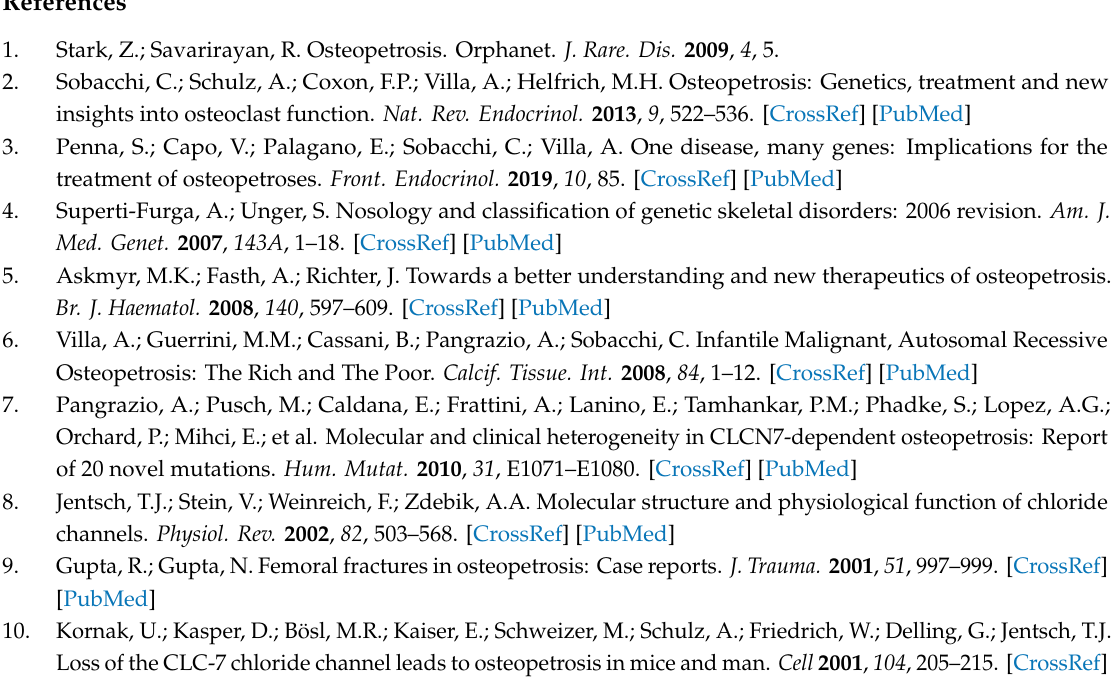
Figure S1: Predicted domain architecture of the CLCN7 protein, Figure S2: Neighbor-joining phylogenetic tree of CLCN7 paralogs identified in the human genome, Figure S3: Neighbor-joining phylogenetic tree of CLCN7 orthologs from representative metazoan genomes, Figure S4: Separation of CLCN7 orthologs from the closely related paralogs. Table S1: Clinical features of the proband, Table S2: Functional e ff ect of mutation L614R by di ff erent SNP